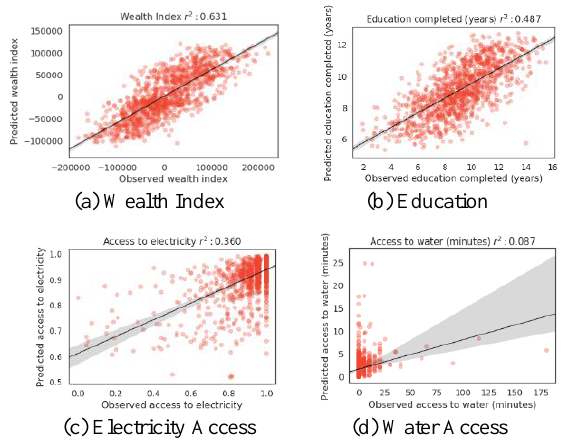
Figure 6. Ground-truth wealth index and cross-validated Philippine poverty predictions using the OpenStreetMap